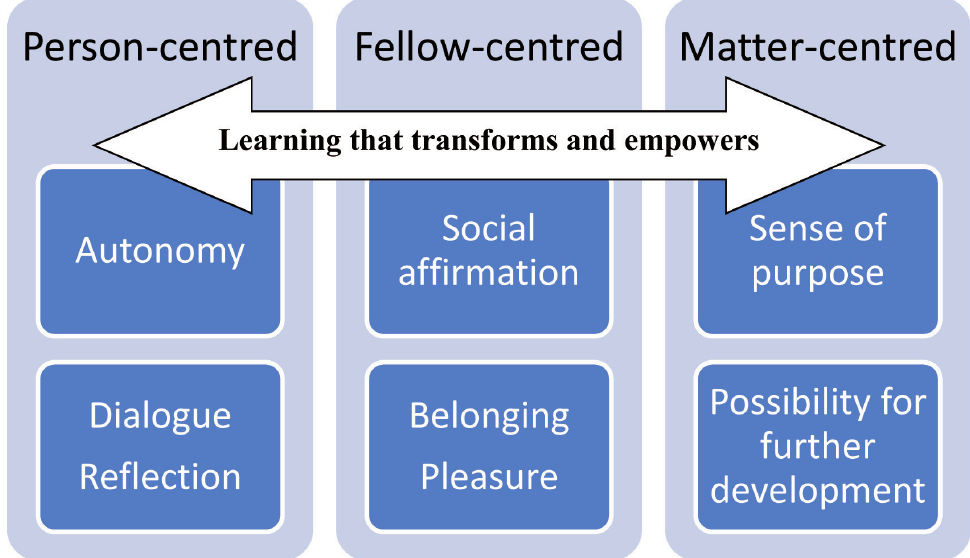
Figure 1: A theoretical framework for critical